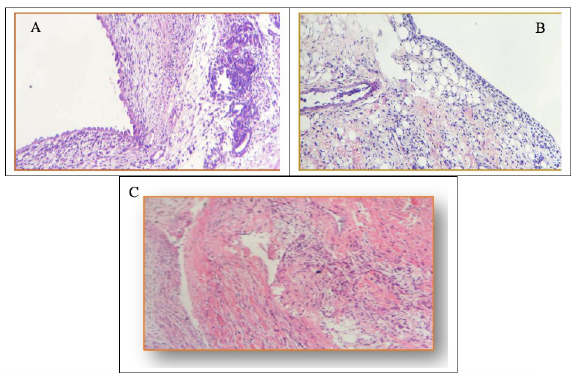
Fig 4. Histopathological analysis of the synovial membrane. A) Edema and moderate chronic lymphoplasmacytic inflammatory infiltrate with formation of lymphoid follicle and synovial hyperplasia. B) Edema and moderate chronic lymphoplasmacytic inflammatory infiltrate with focal areas of fibrosis. C) Inflammatory infiltrate with intense fibrosis of the synovial membrane.